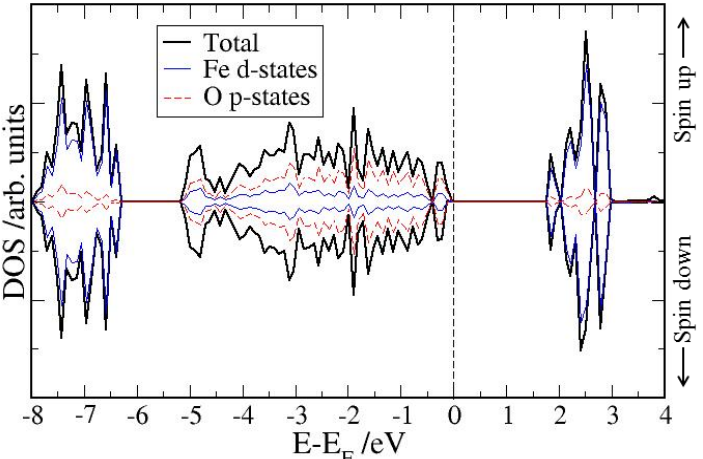
Figure 7. Density of states of the α-Fe level is set to zero as shown by the dashed